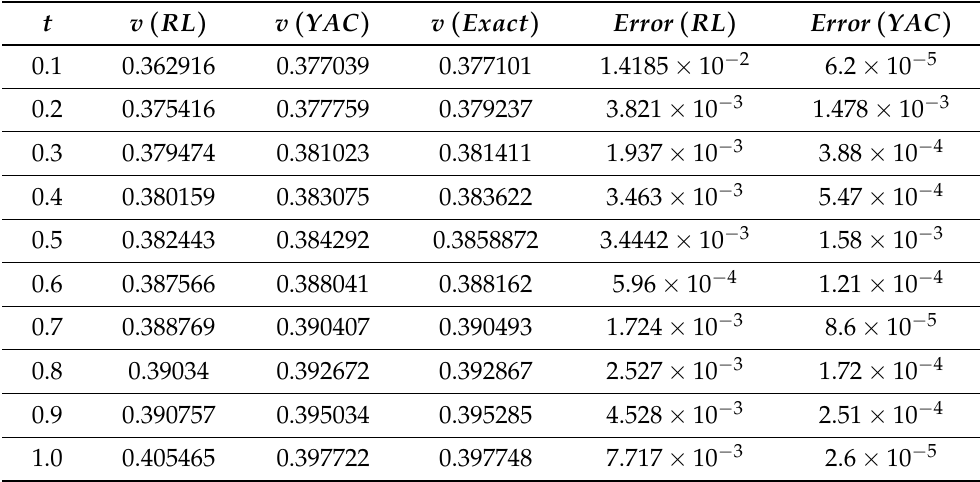
Table 2. Comaprison of α − HATM Solution in sense of YAC derivative operator, RL derivative operator and exact solution for Case